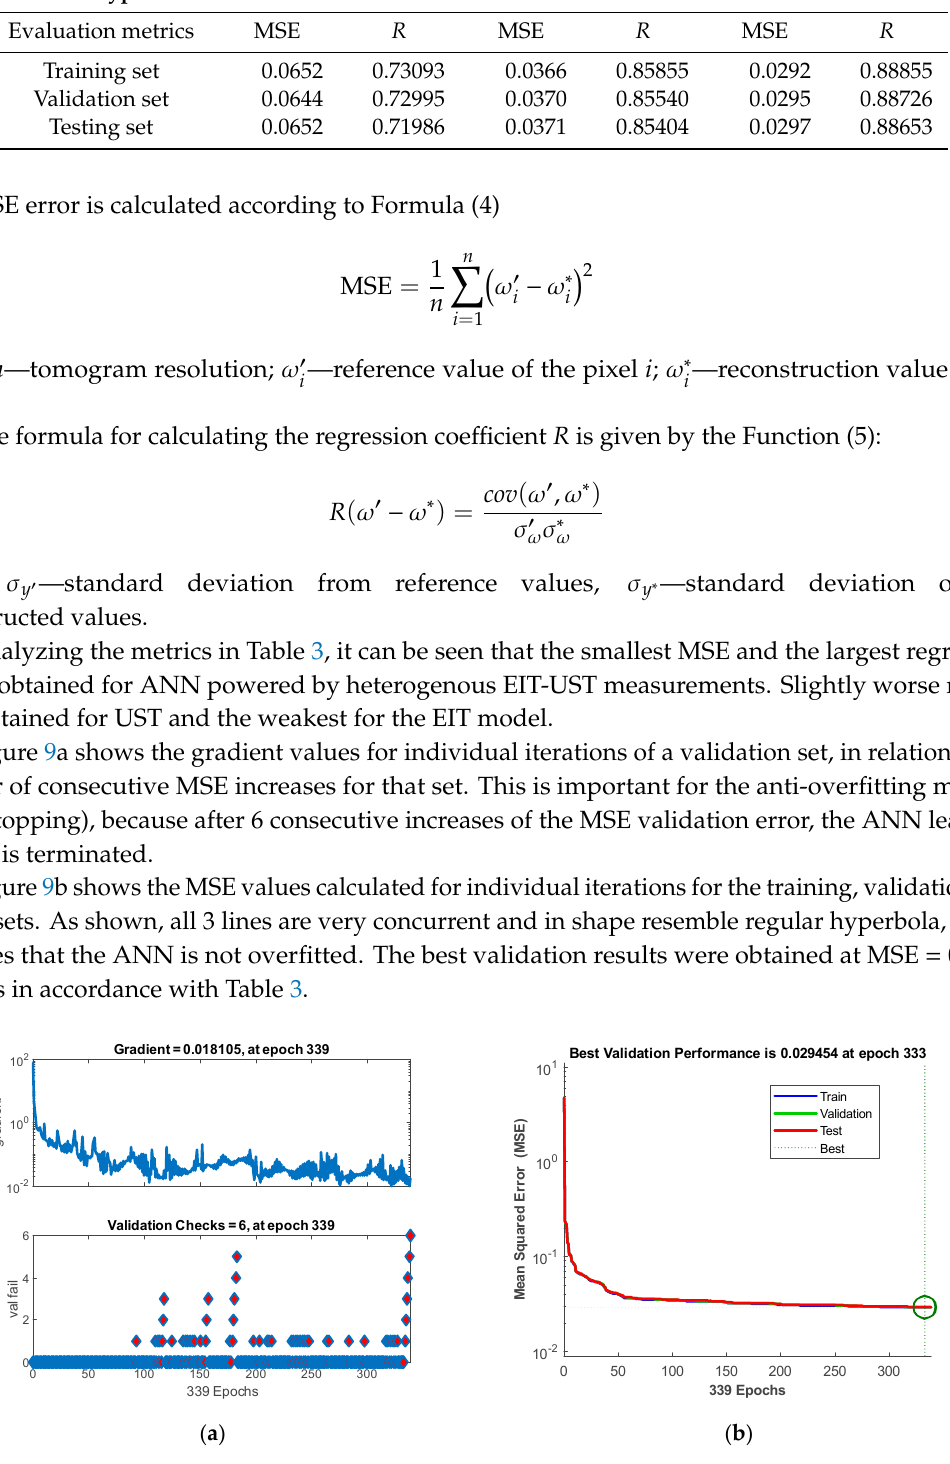
Figure 9. The training and validation process of the EIT-UST network: ( a ) early stopping method; ( b ) performance chart through the mean square error (MSE).